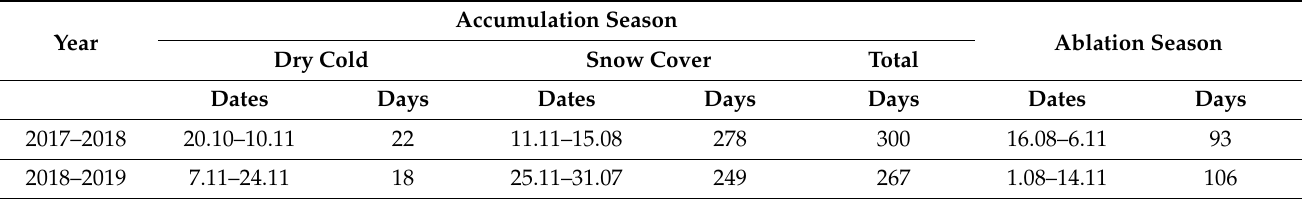
Table 6. Actual duration of accumulation and ablation seasons according to the data of the ground temperature at Banski suhodol